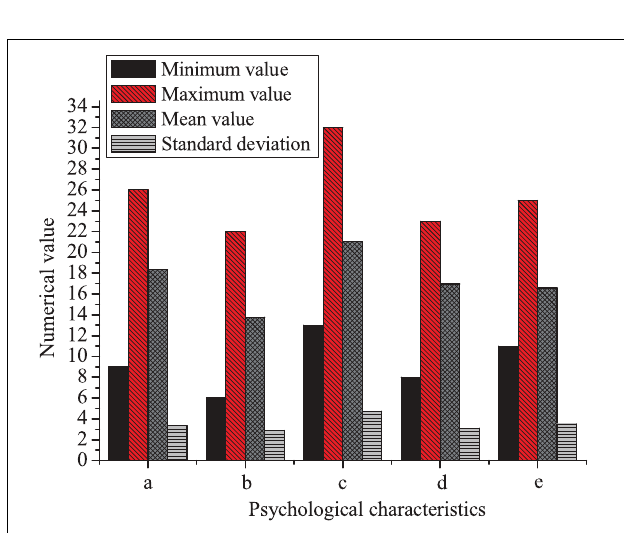
FIGURE 6 | Statistical results of the scores of the psychological characteristics of entrepreneurs (a: success motivation; b: risk bias; c: tolerance; d: control tendency; e: self-confidence).